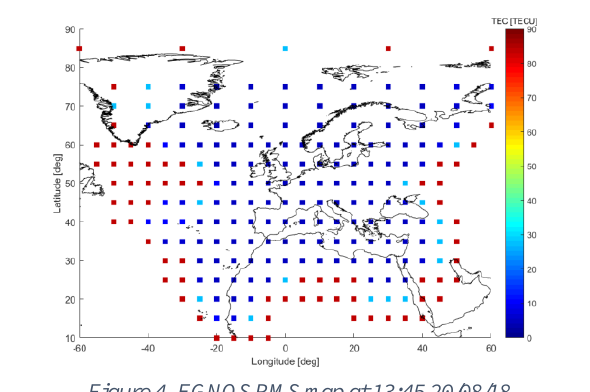
Figure 4. EGNOS RMS map at 13:45 20/08/18. The RMS map shows how the precision of the model rapidly decreases near the edge (Figure 3 and Figure 4).